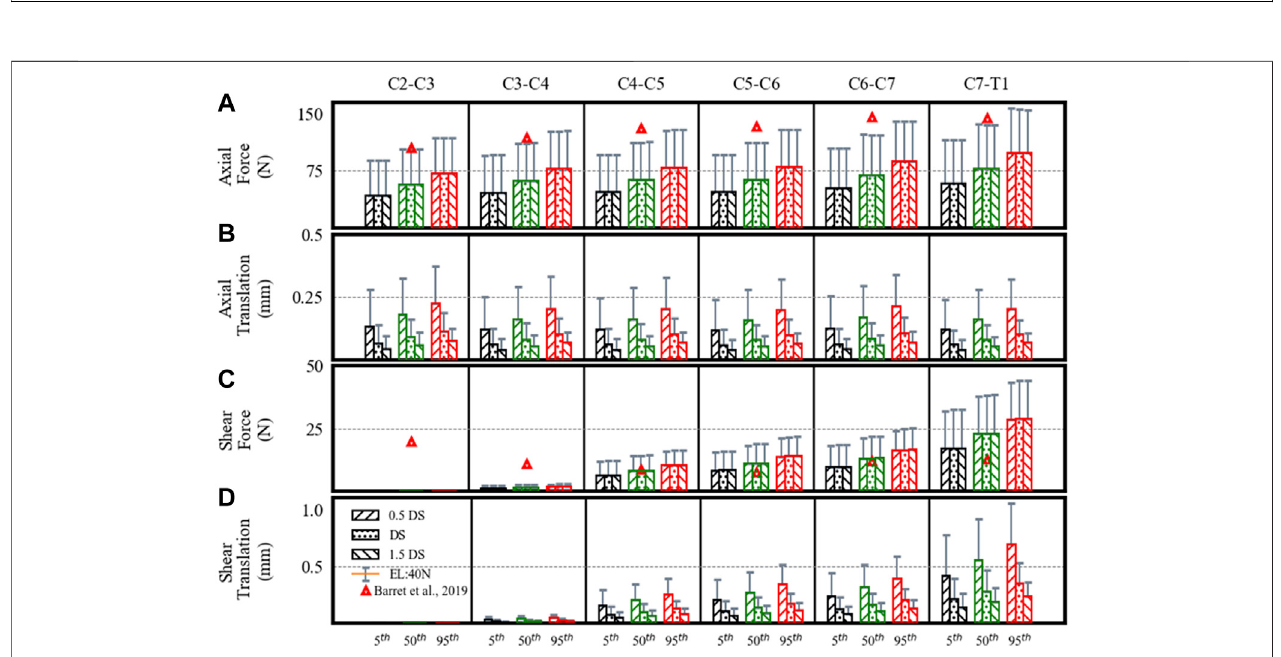
FIGURE 3 | Estimated disc loads and translations in a neutral posture showing differences for the 5th, 50th, and 95th percentile segmental mass, 0.5DS, DS, and 1.5DS discstiffness (DS). (A) Axialforce. (B) Axial translation. (C) Shear force. (D) Sheartranslation.Barsand errorbars showdiscloadsand translations at 0Nand40N external load